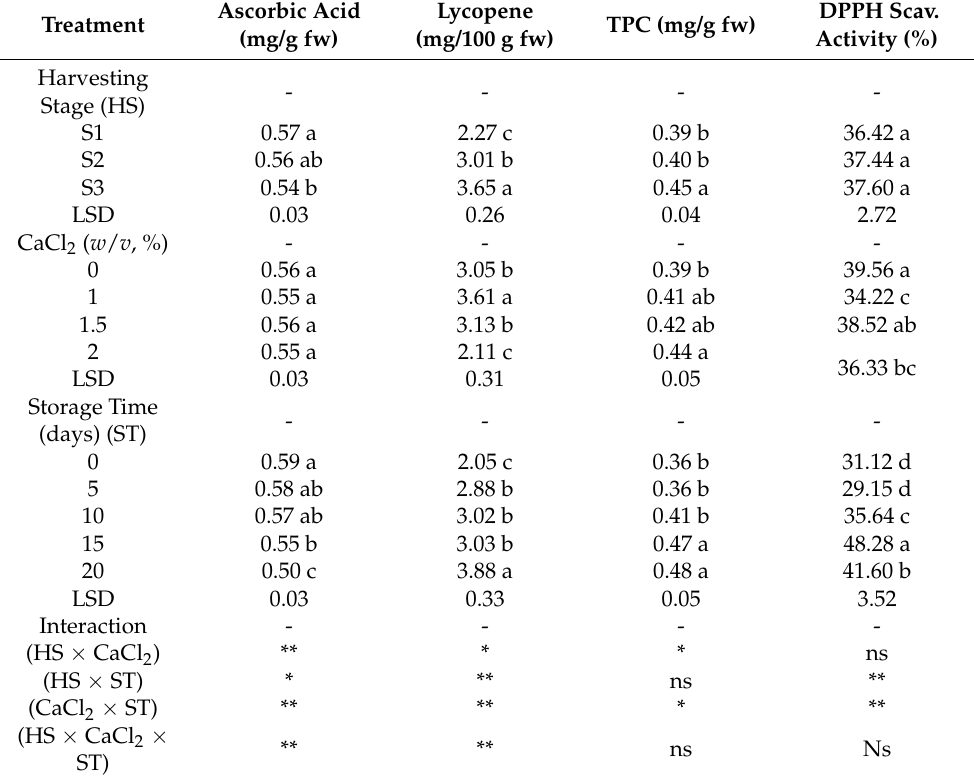
Table 2. Main and interaction effects of harvesting stages (mature green S1, breaker S2, and half ripe S3), concentrations of CaCl 2 (0, 1%, 1.5% and 2%, w / v ), and storage durations (0, 5, 10, 15, and